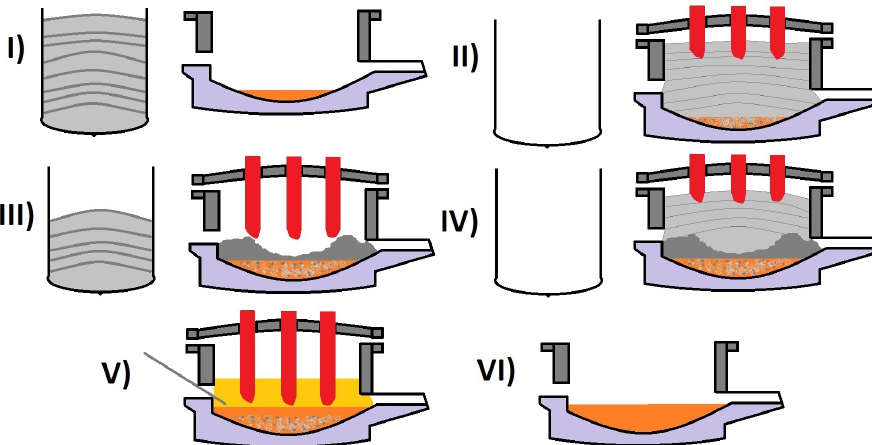
Figure 1. The Electric Arc Furnace (EAF) process in the steel plant considered in the current article. It shows the process divided into six parts. ( I ) The first scrap basket is fully charged with up to 10 layers of scrap. The furnace shell contains hot heel. ( II ) The scrap from the first basket has been charged into the furnace whereupon the lowermost scrap layers intermix with the hot heel. The furnace arcs are bored down into the scrap and the transformer is powered on. ( III ) After the first melting phase the furnace contains a steel scrap-melt mixture and heaps of partially solid scrap. The second scrap basket is charged in as much to fully fill the furnace in the next step. ( IV ) Charging of the second basket. ( V ) Refining of the molten steel where injected carbon and oxygen lancing facilitate an even layer of foaming slag. ( VI ) The heat is ready for